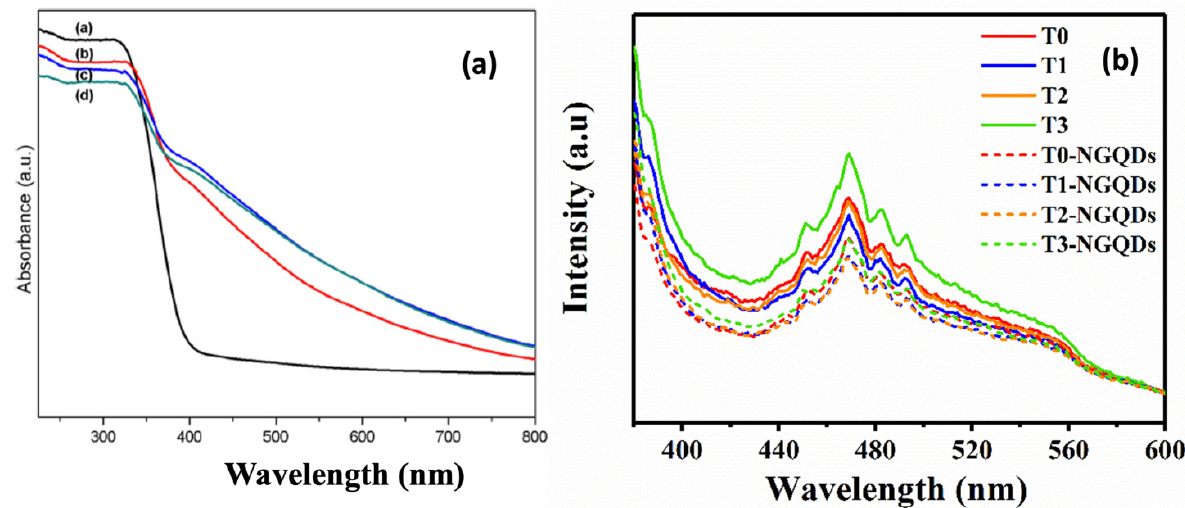
Figure 18. ( a ) UV–visible, ( b ) PL spectra of TiO 2 and TiO 2 -GQD nanocomposites. ( a ) reprinted from [108]. Copyright 2018 Springer Nature. ( b ) reprinted from [109], published by Catalysts.